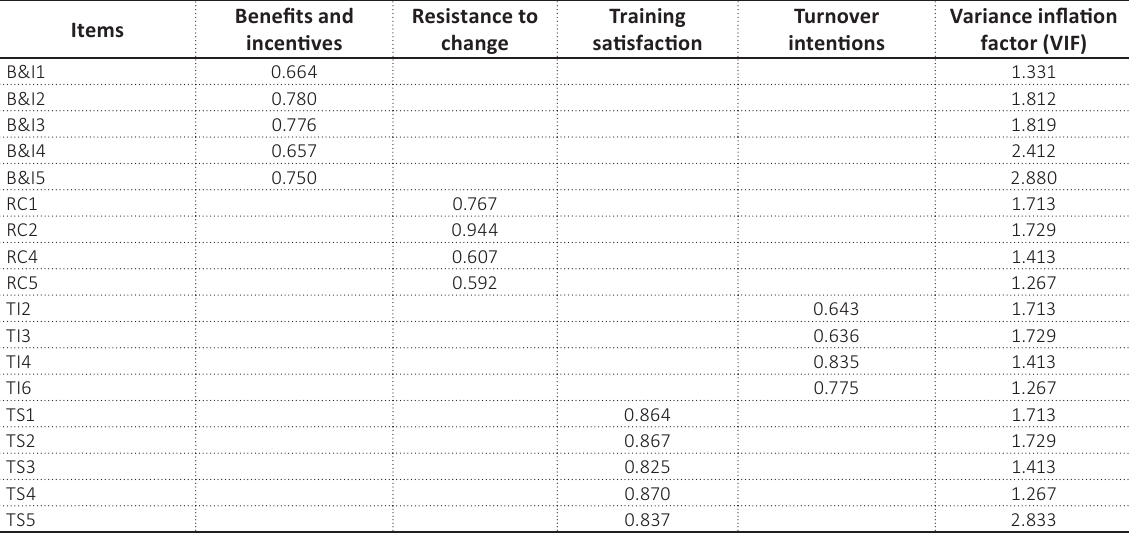
Table 5. Test of discriminant validity Fornell-Lacker criterion